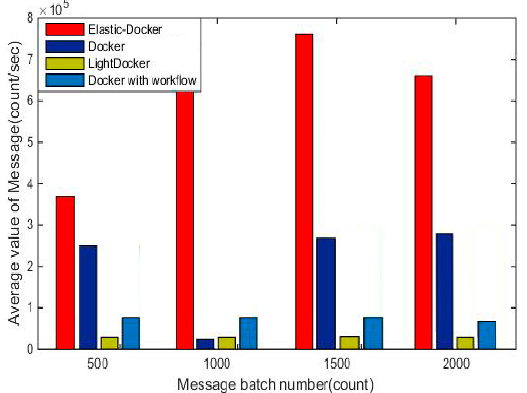
Figure 8. Comparison of the average throughput.